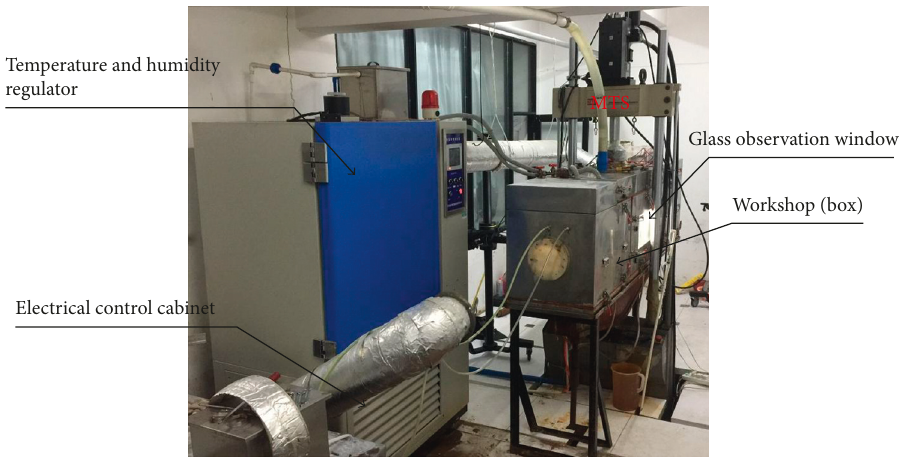
Figure 2: Intelligent environment simulation and controlling